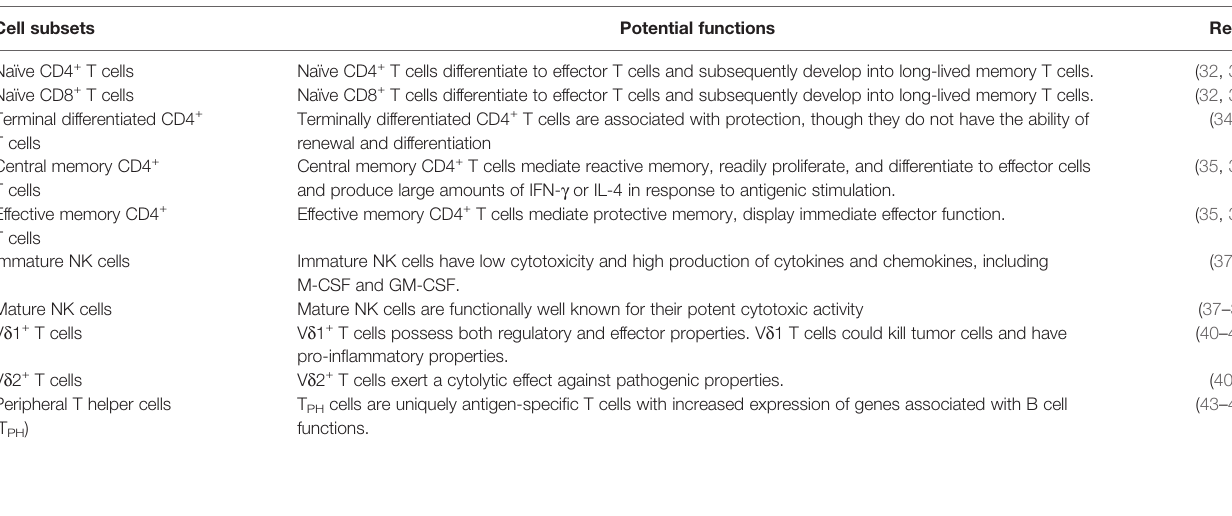
TABLE 2 | Potential functions of signi fi cantly different immune cell subsets. Cell